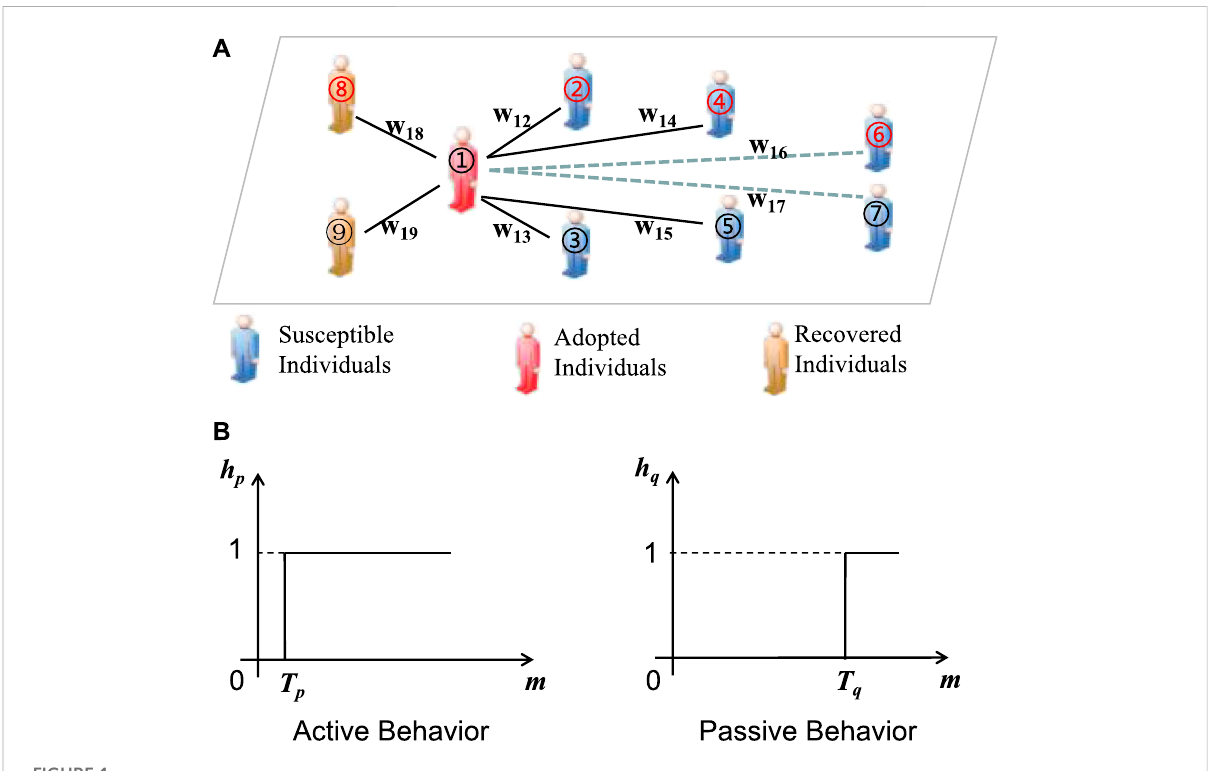
FIGURE 1 (A) SARmodel descriptionon weighted networks.Red labelsrepresent active students,suchas Nos.2, 4,6and8. Blacklabels representpassive students such as students 3, 5, 7, 9. The symbol ω is edge-weight. At t , A-State Student 1 disseminates information to his/her classmates or friends. Information cannot be transferred over the edge, as indicated by the dotted lines. Information is not sent across the corresponding borders of solid lines, as indicated. (B) The left subgraph shows the behavior of active students using a threshold model. The right subgraph is a threshold threshold model passive student behavior adoption. m is the sum of all the information that S-level students have successfully obtained. p and q are the scores of active and passive students,